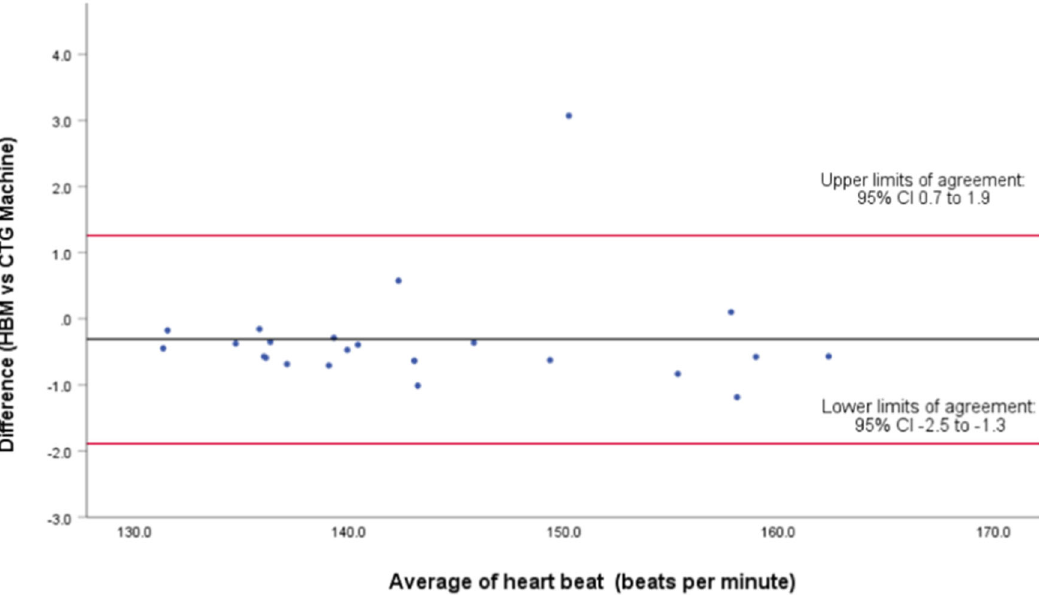
Fig. 3 Bland-Altman plot. Difference in heart rate (beats per minute) between 23 pairs of cardiographs recorded by the fetal heartbeat monitor without-belt stabilisation and